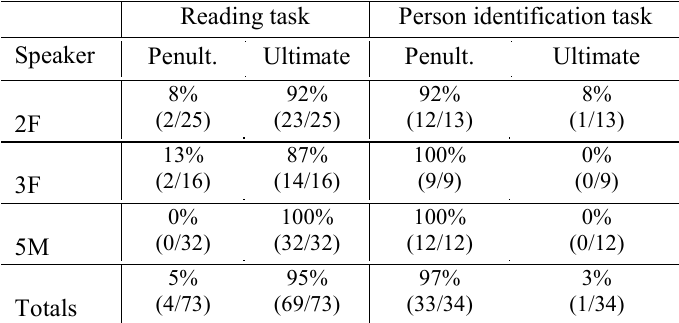
Table 4. Alignment of final rises produced according to